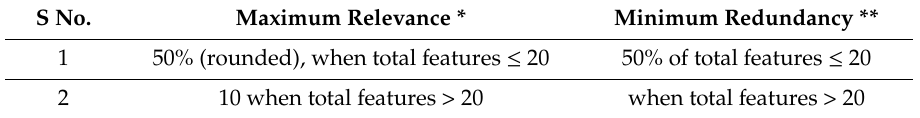
Table 3. Size of feature sets retained for computing maximum relevance and minimum